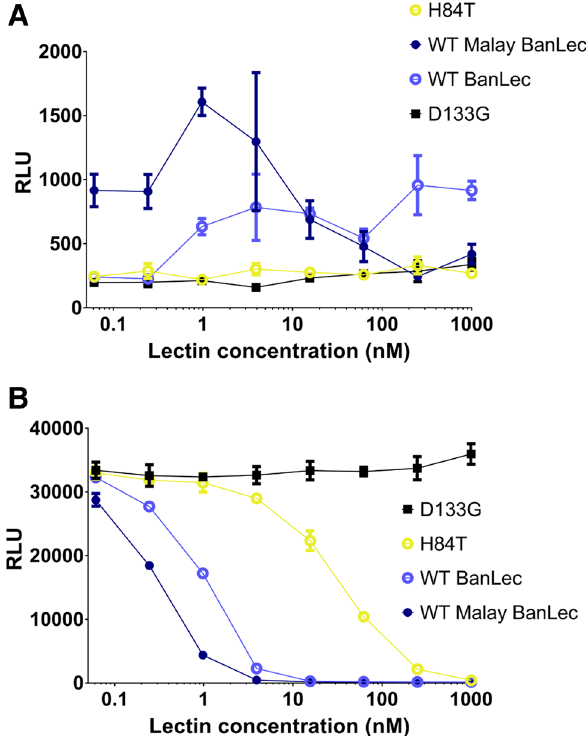
Figure 2. Malay BanLec has both mitogenic and antiviral activity. ( a ) BrdU incorporation into peripheral blood lymphocytes (PBLs). PBLs from a healthy human donor were treated with a range of concentrations of WT, H84T, or D133G BanLec, or Malay BanLec for 3 d and then BrdU incorporation over 18 h was measured by chemiluminescent ELISA. RLU relative light units. ( b ) TZM-bl cells were pre-treated with the same lectins as in A and exposed to HIV BaL for 2 days. To assess levels of infection, luciferase activity was measured. Data in A and B are representative of one independent experiment each. Error bars represent the SEM of triplicate values. The figure was generated using GraphPad Prism 7 (https ://www.graph pad.com/scien tific -softw are/prism /) and Adobe Illustrator, version 22.1.0 (https ://www.adobe .com/produ cts/illus trato